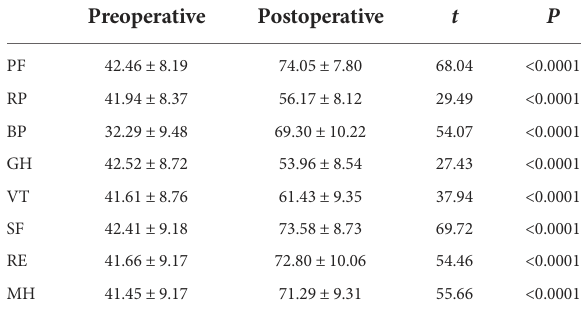
TABLE 2 Comparison of quality of life scores before and after lumbar fusion according to the MOS SF-36.